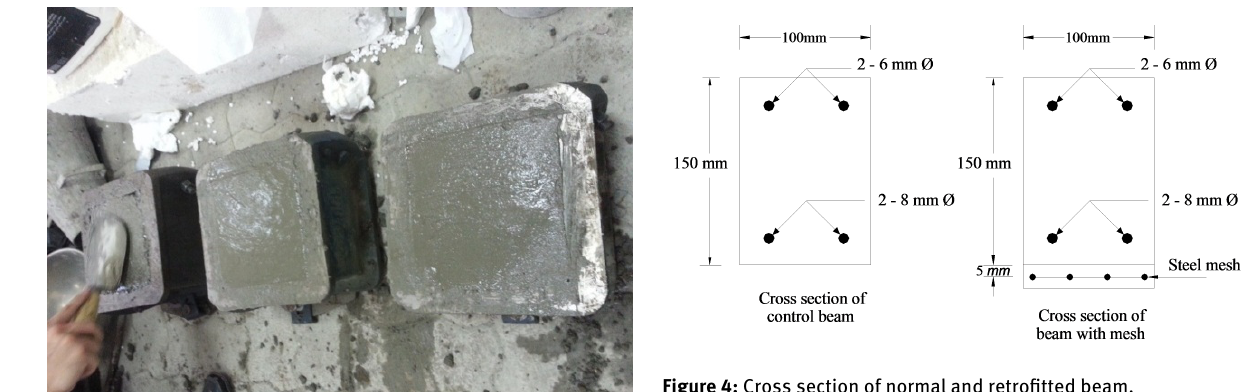
Figure 4: Cross section of normal and retrofitted beam.